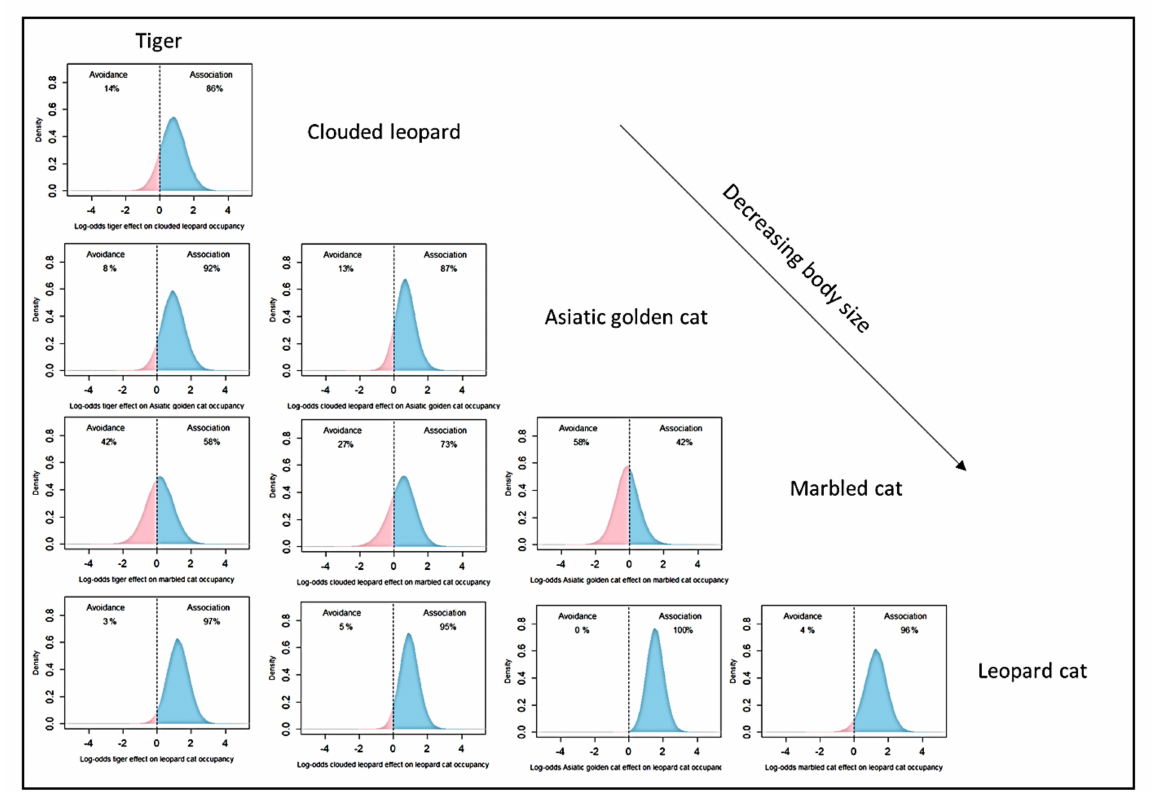
Figure 4. Spatial association and avoidance between tiger, clouded leopard, Asiatic golden cat, marbled cat, and leopard cat based on a multi-species spatial interaction model. This shows the log-odds ratio of dominant species to subordinate species (Blue shade: Probability of association, Pink shade: Probability of avoidance).